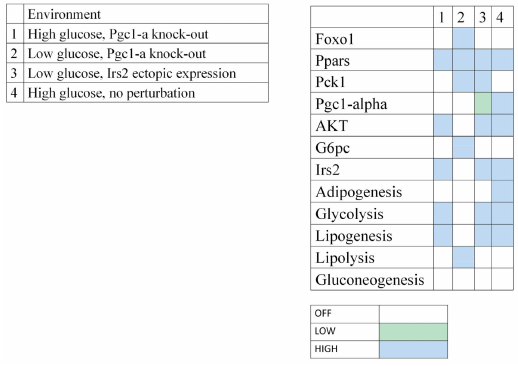
Figure 7. Model simulations in scenarios with perturbations. Context-dependent stable states computed for the model. Blank cell = inactivation of the corresponding component; blue cell = maximal activation (1 for Boolean components, 2 for Pgc-1 α ); green cell = intermediate level (1 for Pgc-1 α